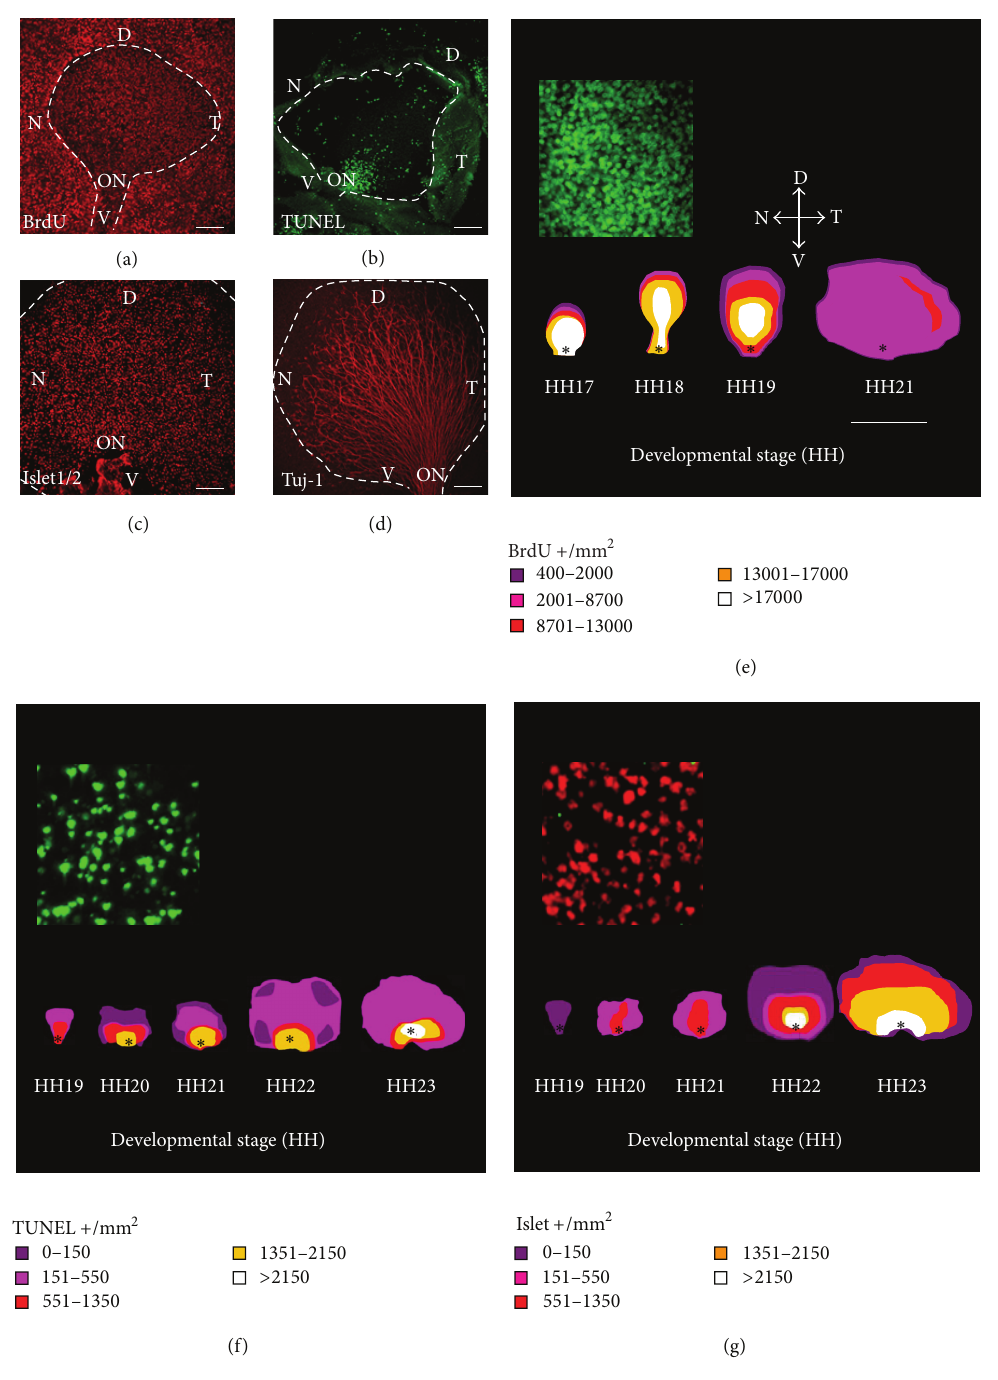
Figure 1: Overlapping cell processes in the embryonic chick retina. Representative labeling of cell proliferation (a), death (b), and differentiation (c), (d) in retinal whole mounts from chick embryos ((a), HH19; (b), HH20; (c), HH23; (d), HH21). Positive cells were scored in 4–6 retinas from different embryos and represented on isodensity maps of the different processes (e)–(g). The insets show positive cells at higher magnification, as employed for scoring. The main morphological features are labeled as follows. ON and ∗ : optic nerve; D: dorsal; V: ventral; T: temporal; and, N: nasal. Scale bars represent 80 𝜇 m (a)–(d), 500 𝜇 m (e)–(g), and 40 𝜇 m